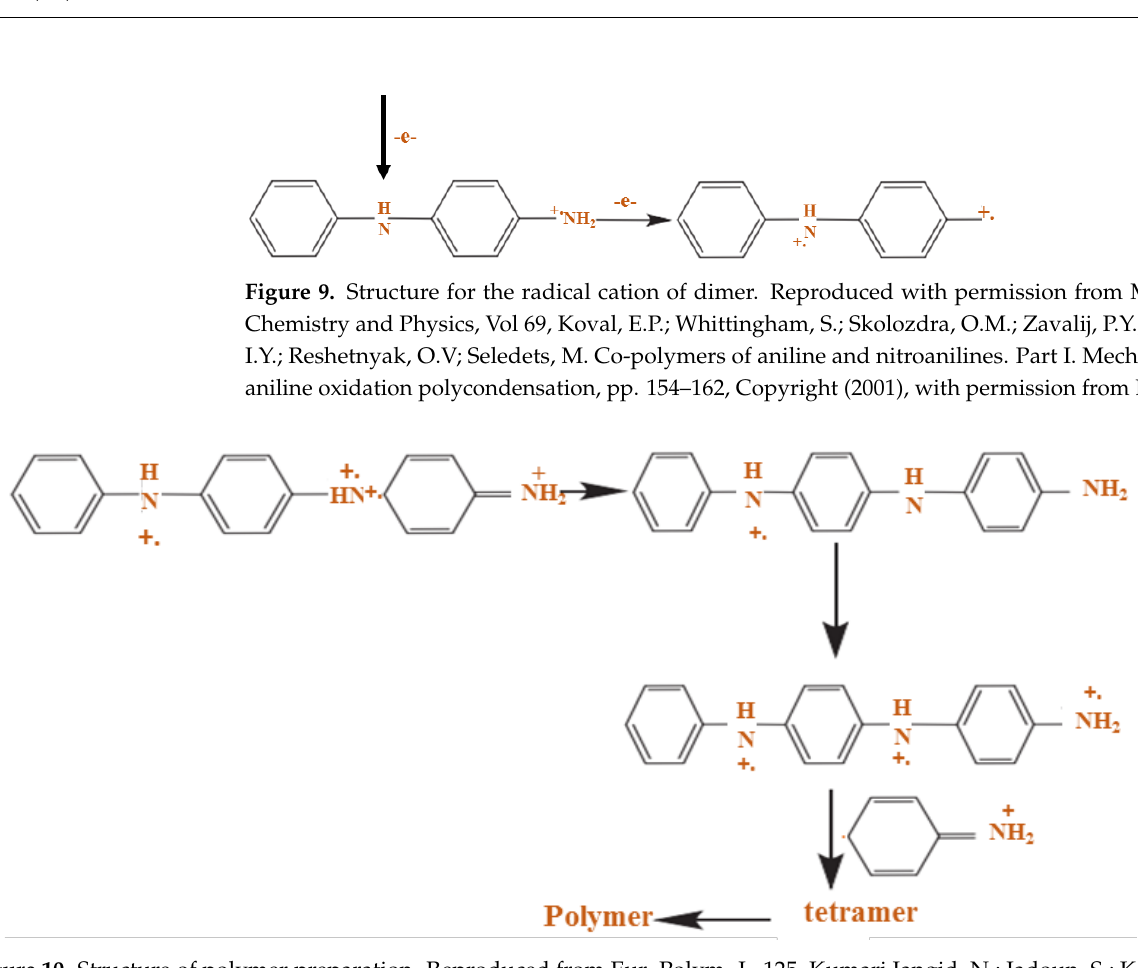
Figure 10. Structure of polymer preparation. Reproduced from Eur. Polym. J., 125, Kumari Jangid, N.; Jadoun, S.; Kaur, N., A review on high-throughput synthesis, deposition of thin films, and properties of polyaniline, Copyright (2020), with permission from Elsevier.